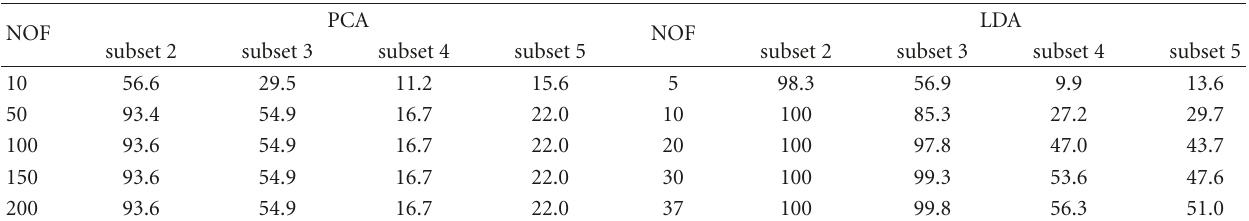
Figure 12: Sample images of one subject from the AR database taken at the first photo session. The images exhibit the following characteristics: (upper row—from left to right) neutral face (N), happy face (H), angry face (A), screaming face (SC), left light (L), right light (R), and frontal light (F); (lower row—from left to right) occluded by glasses (G), occluded by glasses and lit from left (GL), occluded by glasses and lit from right (GR), occluded by a scarf (S), occluded by a scarf and lit from left (SL), and occluded by a scarf and lit from right (SR). Table 1: Results of the face identification experiments on the EYB database for varying lengths of the PCA and LDA feature